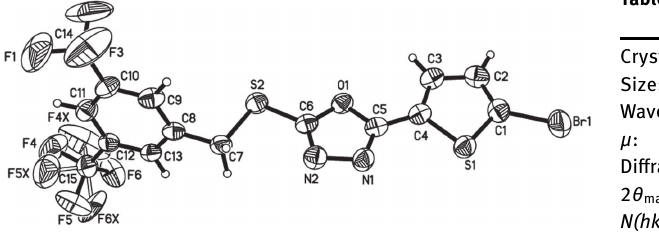
Table 1: Data collection and